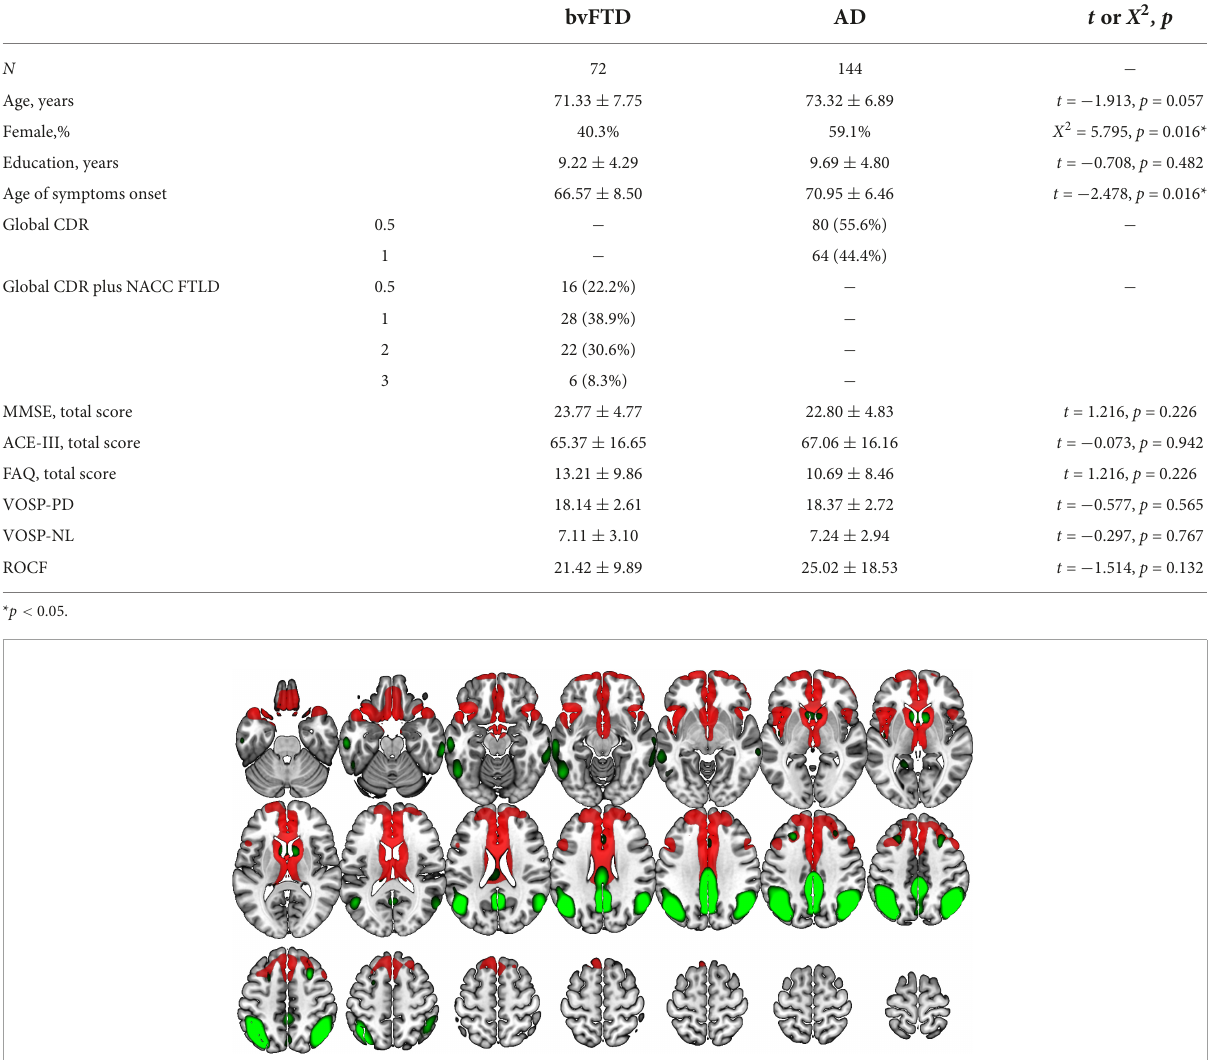
FIGURE1 Voxel-based brain mapping analysis showing brain regions with lower metabolism in the group of bvFTD (red) and AD (green) compared with a healthy control group (FEW-peak corrected p -value < 0.05). Images are shown in neurological